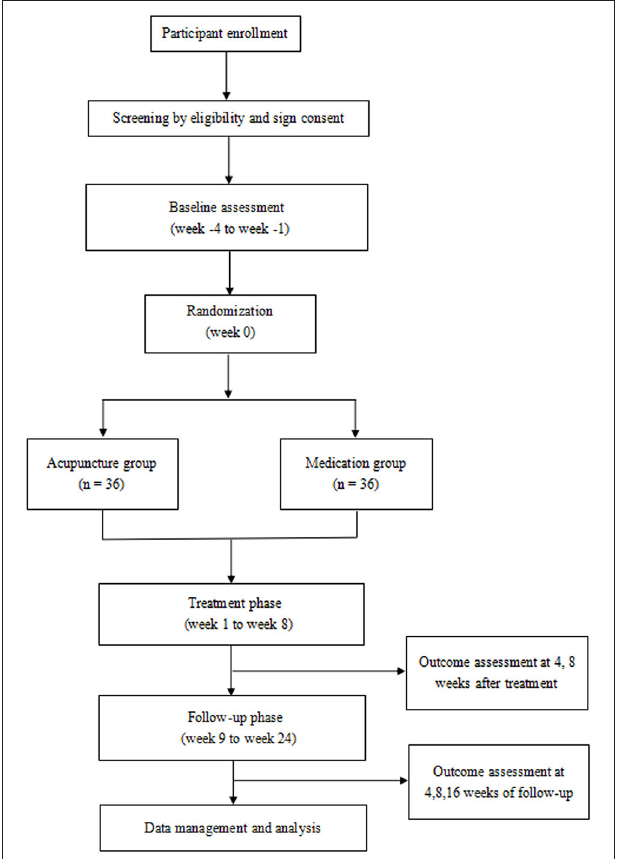
FIGURE 1 | Flow diagram of the study